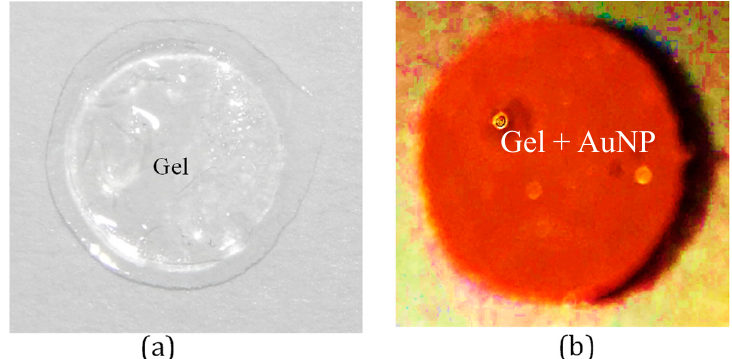
Figure 2. Photograph of the synthesized hydrogel. ( a ) Undoped hydrogel. ( b ) AuNP-doped hydrogel.